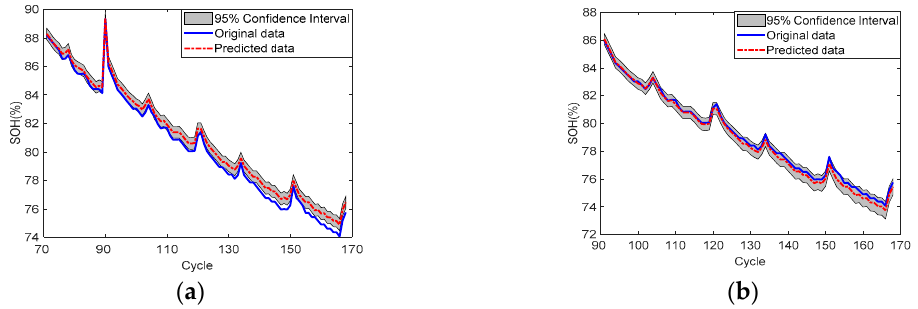
Figure 8. SOH prediction results of battery No. 6: ( a ) SP = 71; ( b ) SP = 91.